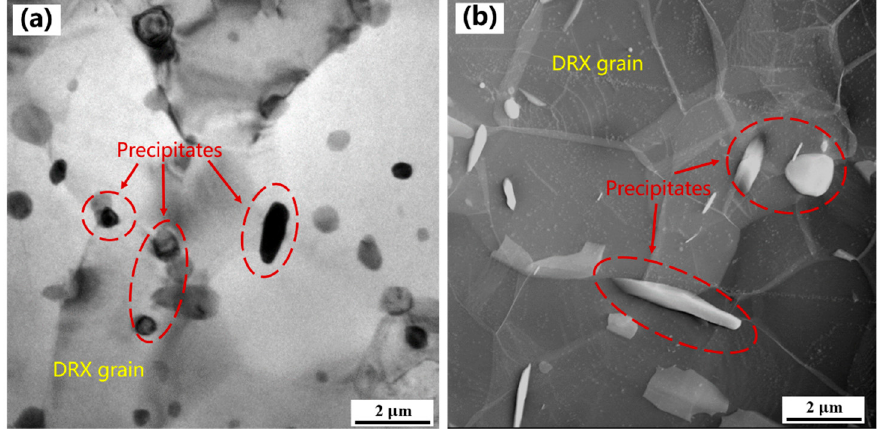
Figure 10. TEM image of AC AA2195 alloy: ( a ) is a TEM bright field image, and ( b ) is a STEM- HAADF image.